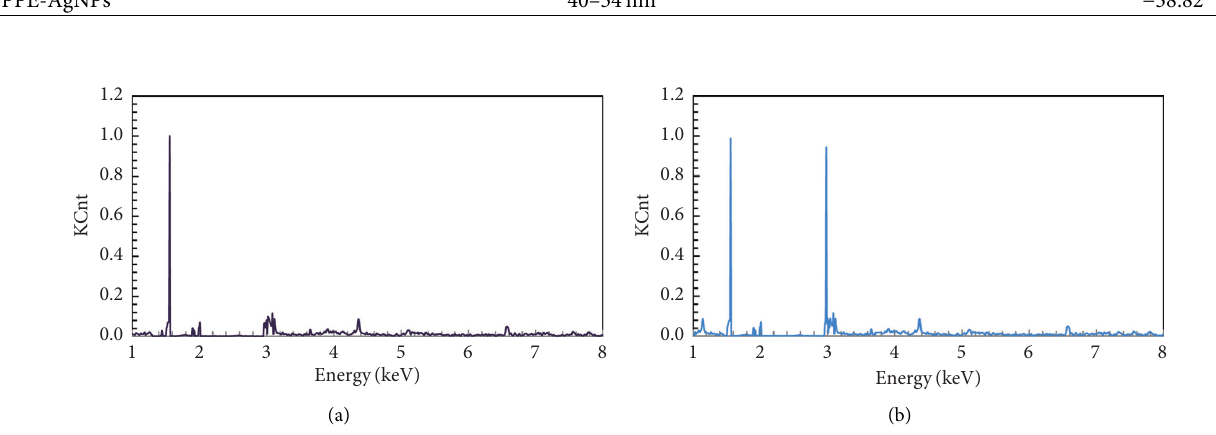
Table 7: Characteristics of AgNPs synthesized using black currant, apricot, grape pomace, and pomegranate peel extracts. System Average particle-sized AgNPs (nm) Zeta potential GPE-AgNPs 50–90nm